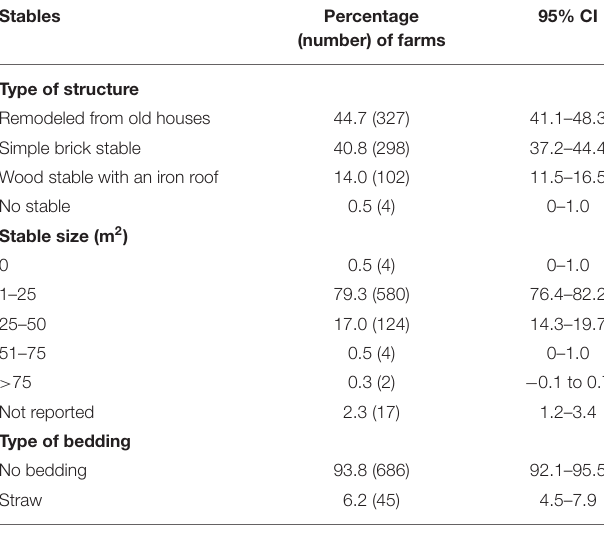
TABLE 2 | Herd size of donkeys across 694 * smallholder farms in Western Liaoning and Eastern Inner Mongolia of China.